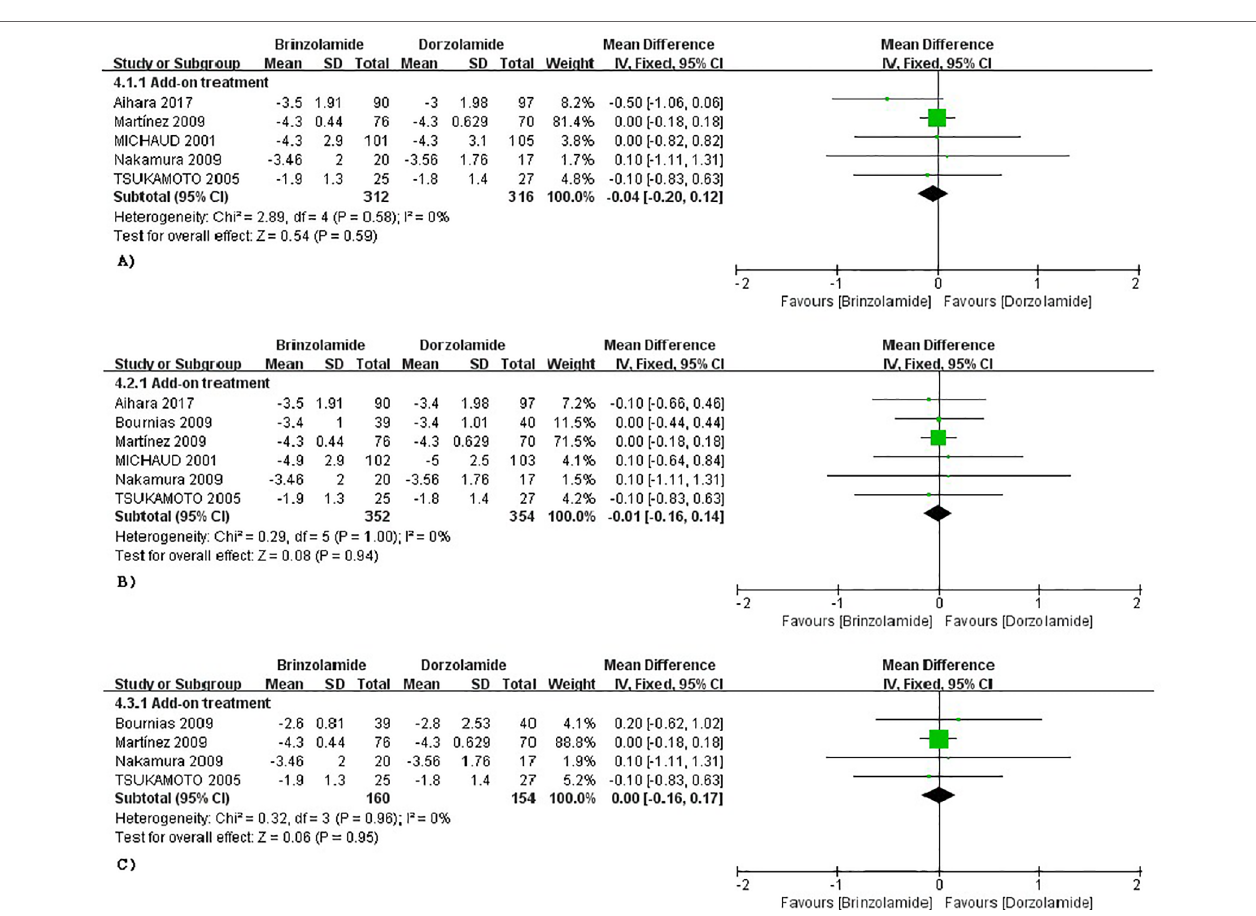
FIGURE 4 | Forest plot for IOP change from baseline (Brinzolamide group vs. Dozorlamide group). The plot of change value for IOP at 9 am (A) , 12 am (B) , 4 pm (C)